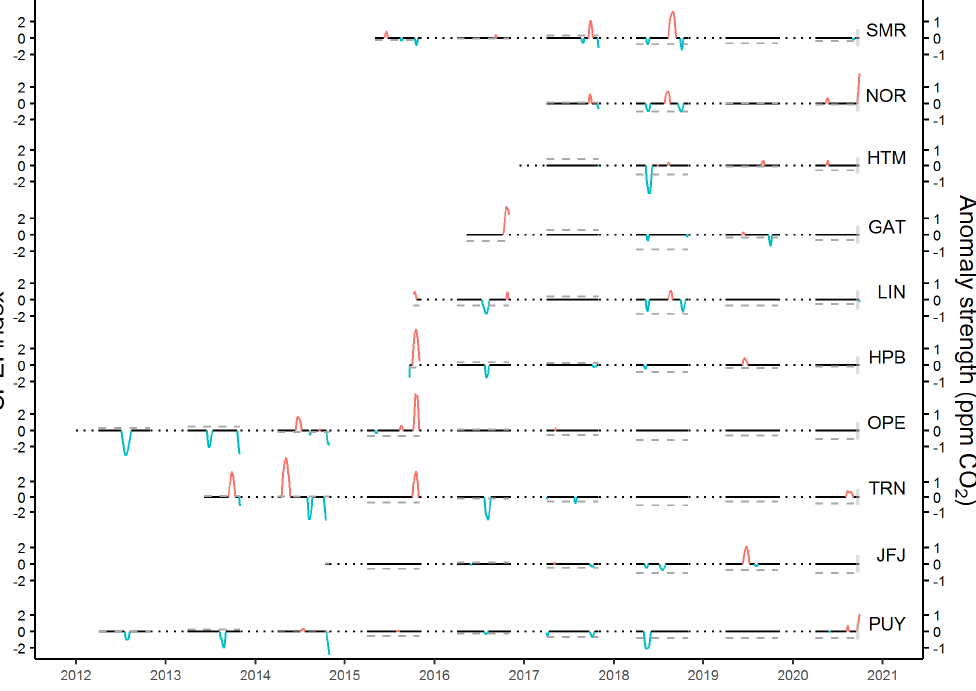
Figure 9. Positive (red) and negative (blue) 90d seasonal CO 2 anomalies. April–October average SPEI values are indicated by the dashed gray lines. The gray bar on the right end of the plots indicates the standard deviation of summer SPEI values from